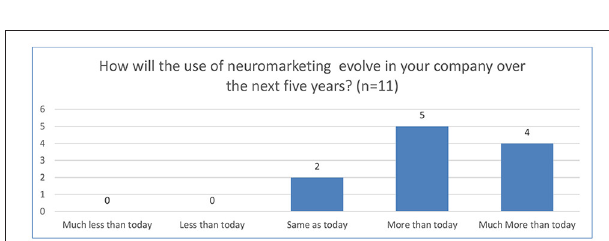
FIGURE 8 | Evolution of neuromarketing in the